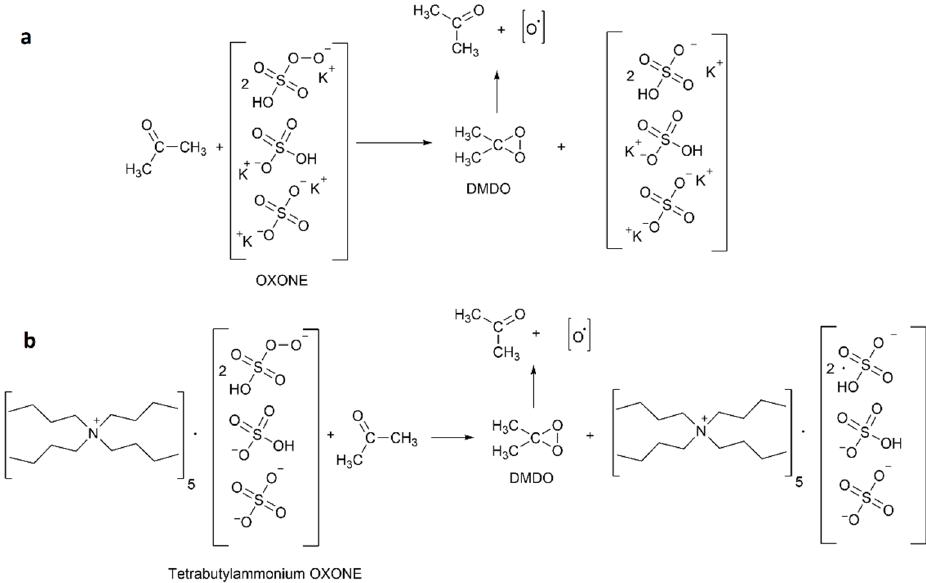
Figure 2. The comparison of the mechanisms of activity of two disinfecting agents: ( a ) OXONE, and ( b ) TBA-OXONE.